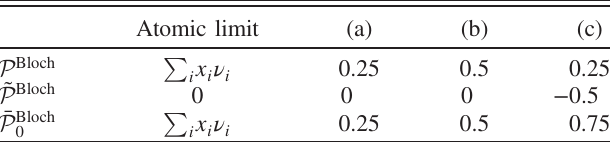
TABLE II. Comparison of Berry phases for 1D band insulators. The atomic limit is the limit of the vanishing hopping with a ν i ( ¼ 0 or 1) localized electron at the site x i . (a) – (c) The model in Eq. (46) illustrated in Fig. 1(a) –